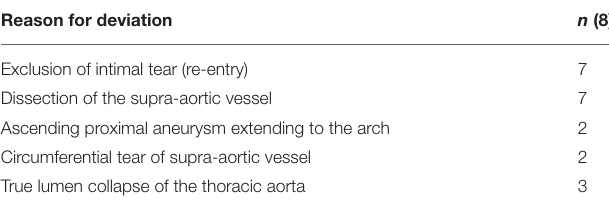
TABLE 1 | Reasons for deviation from zone